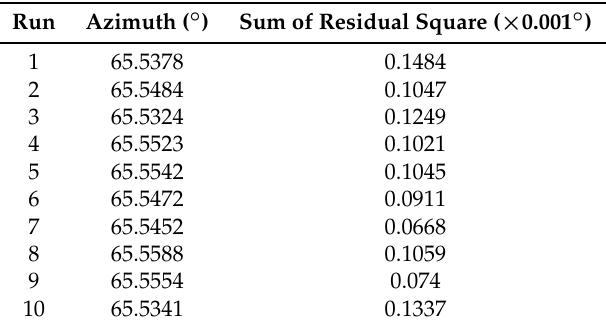
Table 1. Azimuth measurement results with n = 72.